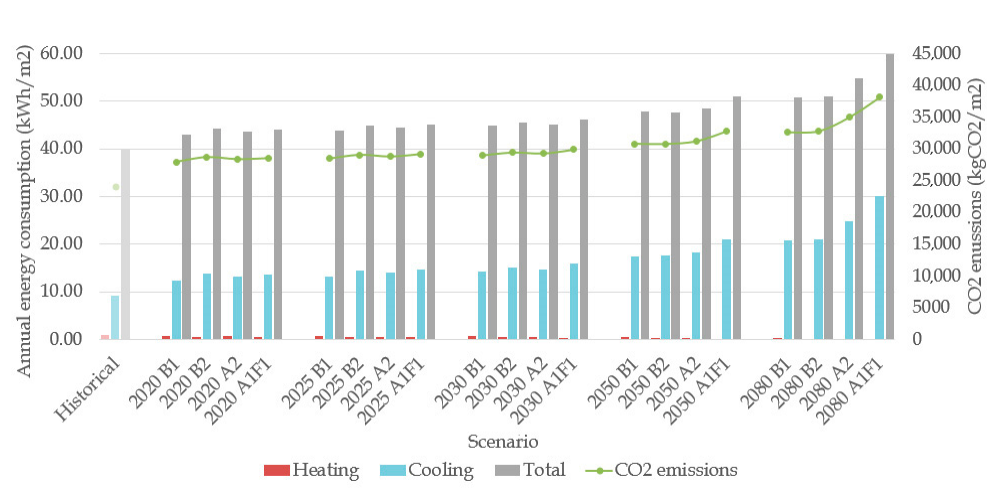
Figure 8. Variation of energy consumption and CO 2 emissions in historical, present, and future scenarios and sub-scenarios.